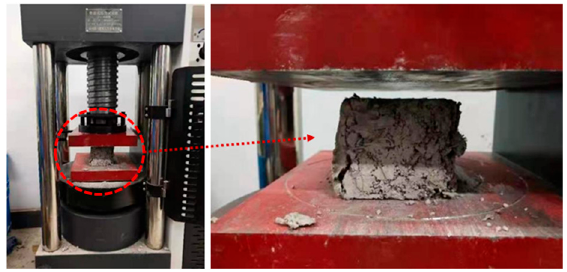
Figure 6. Damage diagram of 20% fiber concrete specimen.